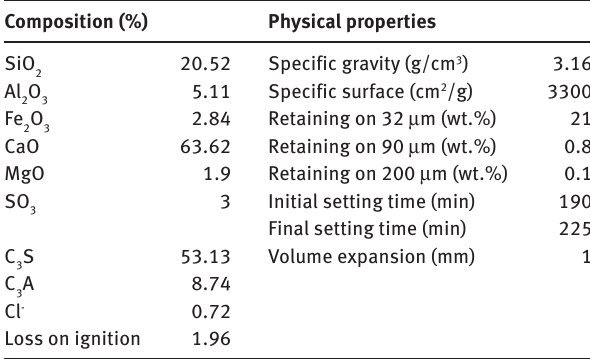
Table 1: Properties of